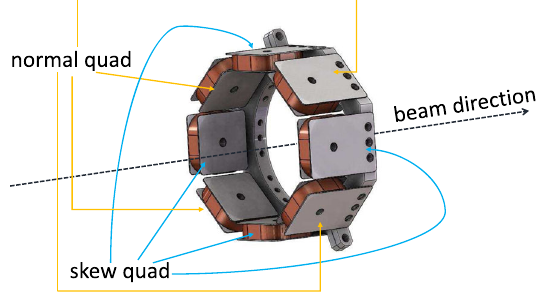
FIG. 11. Left: The solenoid field is in the − z direction for the ccw solenoid current direction, and the rotation angle of the solenoid quadrupole is 12°. Right: The solenoid field is in the þ z direction for the cw solenoid current direction, and the rotation angle of the solenoid quadrupole becomes − 78 °. The rotation angle is defined as the angle between the quadrupole focusing direction and the x-axis.